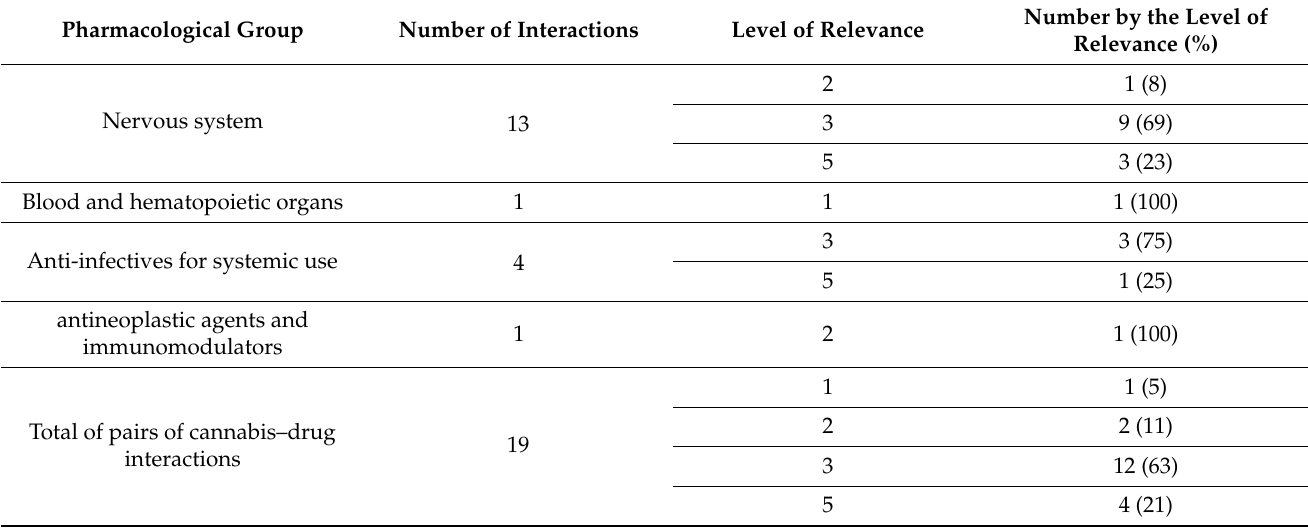
Table 2. Pharmacological group and level of relevance for 19 pairs of cannabis–drug interactions identified.